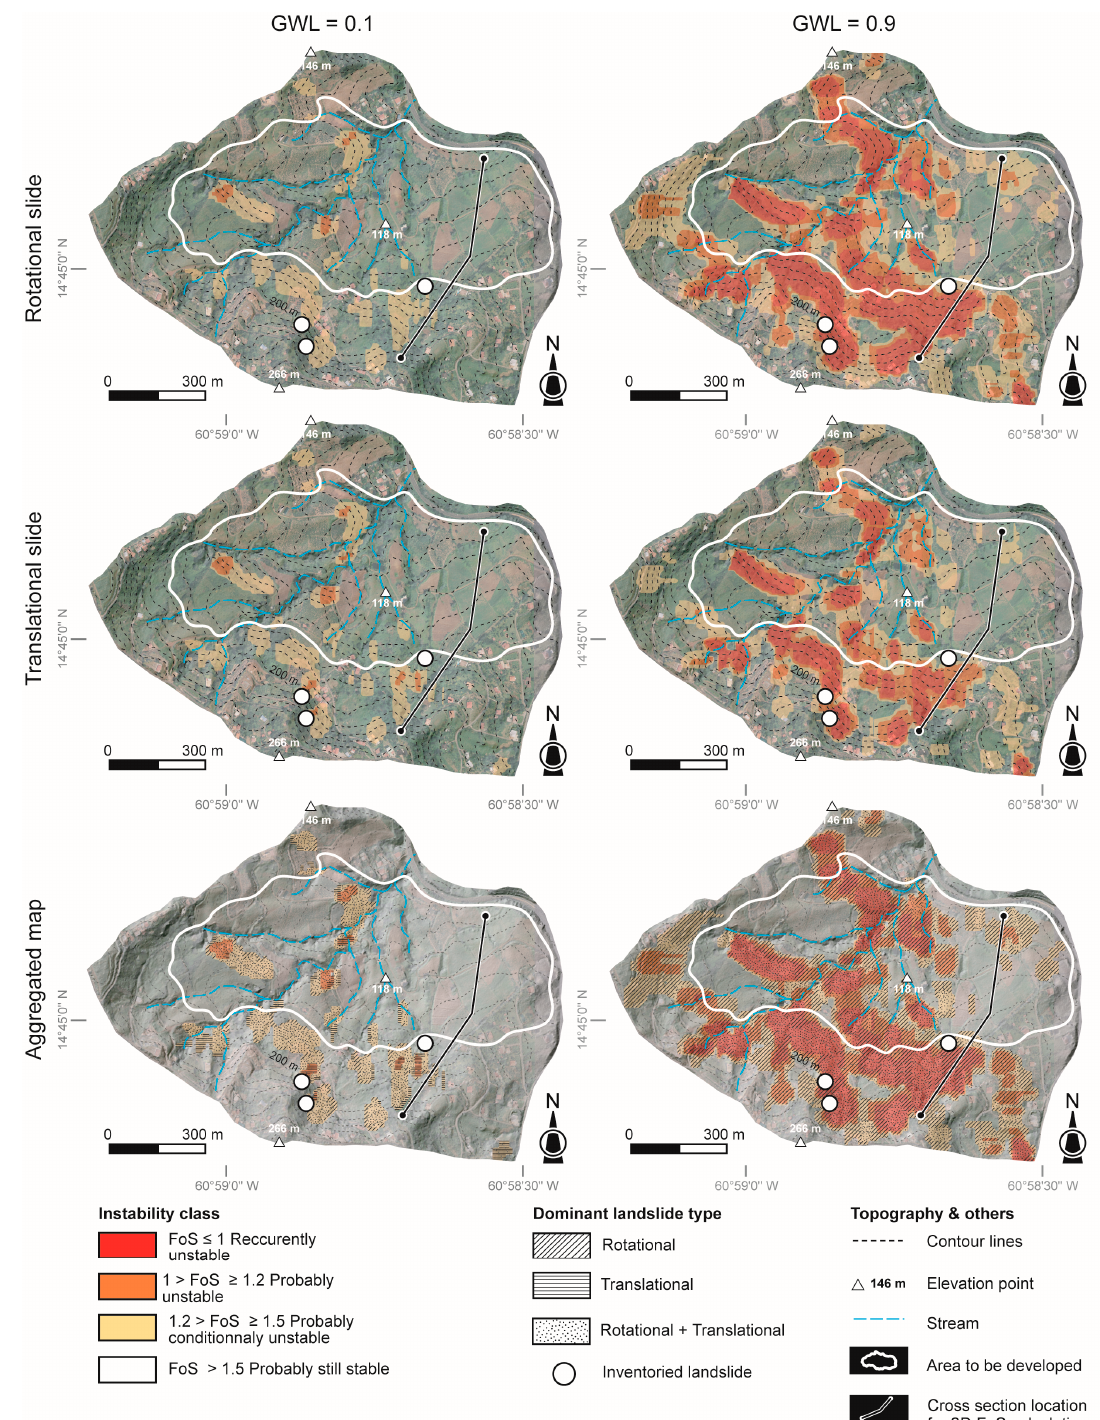
Figure 11. Slope stability maps obtained with ALICE ® for deep landslides (translational + rotational) for dry and saturated conditions (coordinates are expressed in Lat/Long; projection WGS84 UTM 20N—EPSG 32620).